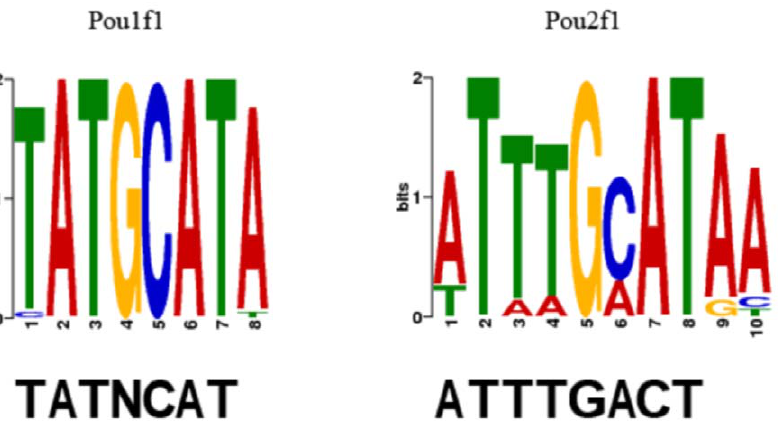
Figure 12. Differentiating between TFs from the same family. At the top of the figure are shown the MEME-predicted sequence logos for Pou1f1 and Pou2f1. Below are shown the binding site consensus sequences from literature [39], [40].